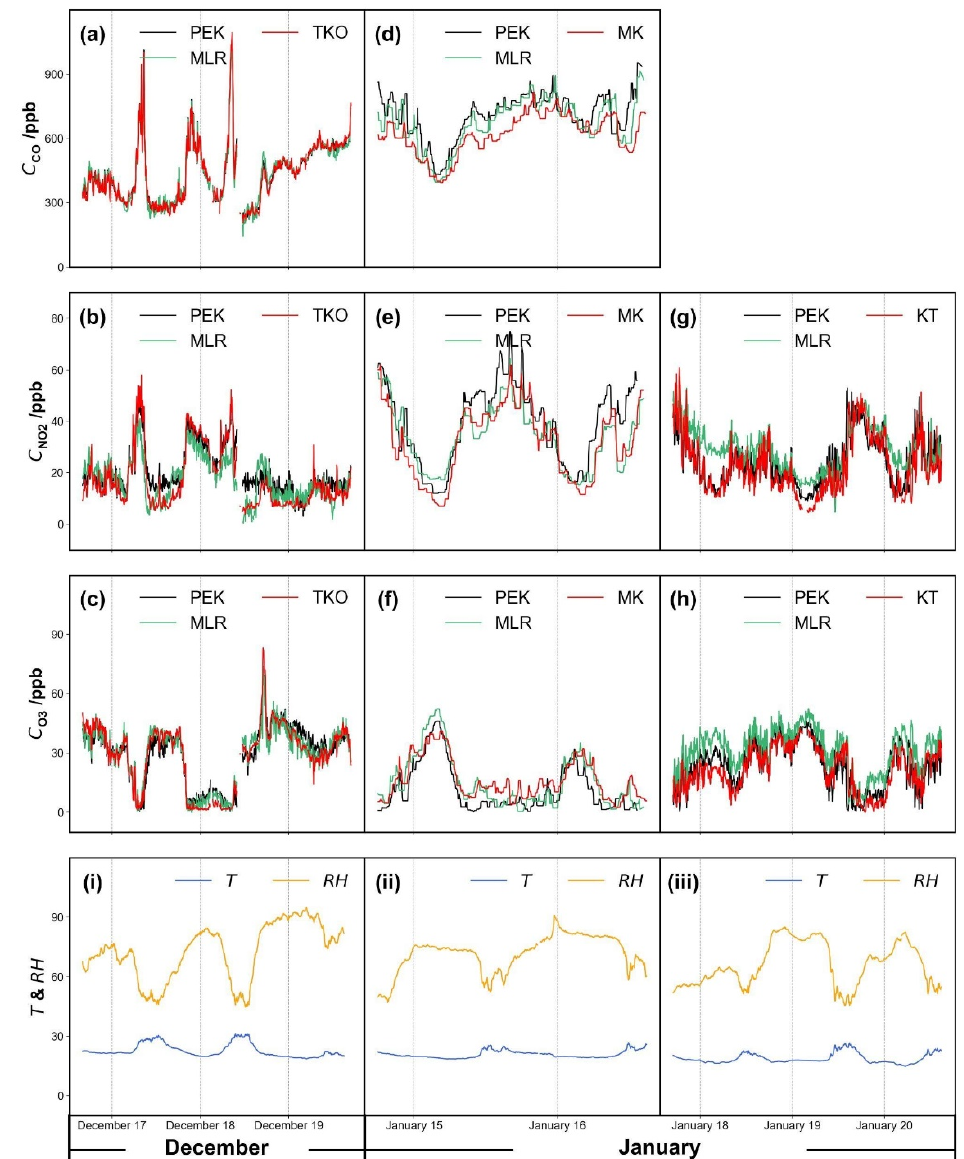
Figure 8. Time series plots of gases across the test period tuned via the multi-linear regression model compared with Personal Exposure Kit (PEK) measurements, which were calibrated following Protocol 2 at the Tseung Kwan O (TKO) site ( a – c ), at Mong Kok (MK) ( d – f ) and Kwun Tong (KT) ( g , h ) air quality monitoring sites under the same ambient conditions, including environmental factors, temperature (15 °C–30 °C) and humidity (45%–90%) ( i – iii ). Data resolution is set as 5 min.